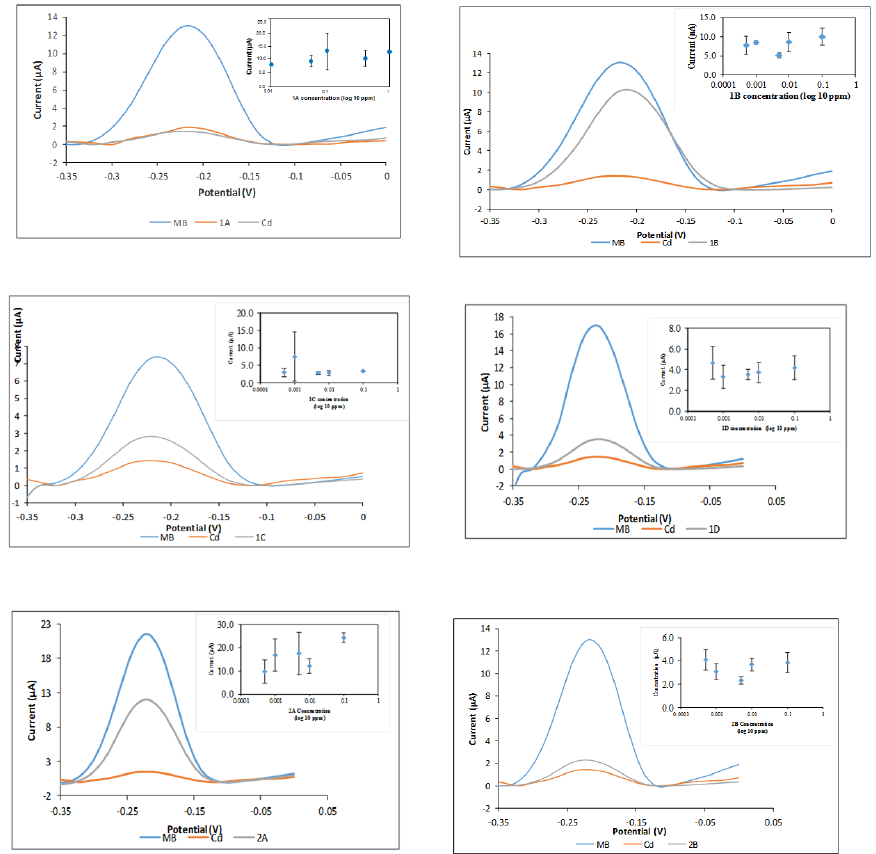
Figure 9. DNA biosensor with pyranopyrazole and quinoline compounds; ethyl 6-amino- 5-cyano-4-phenyl-1,4-dihydropyrano[2,3-c]pyrazole-3-carboxylate ( 1a ), ethyl6-amino-5-cyano-4-(4- ethylphenyl)-1,4-dihydropyrano[2,3-c]pyrazole-3-carboxylate ( 1b ), ethyl6-amino-5-cyano-4-(furan-2- yl)-1,4-dihydropyrano[2,3-c]pyrazole-3-carboxylate ( 1c ), ethyl6-amino-5-cyano-4-isopropyl-1,4- dihydropyrano[2,3-c]pyrazole-3-carboxylate ( 1d ), 2-((7-chloroquinolin-4-yl)amino)ethanol ( 2a ) and N-(2-bromoethyl)-7-chloroquinolin-4-amine ( 2b ). * Large error bars show the non- carcinogenic